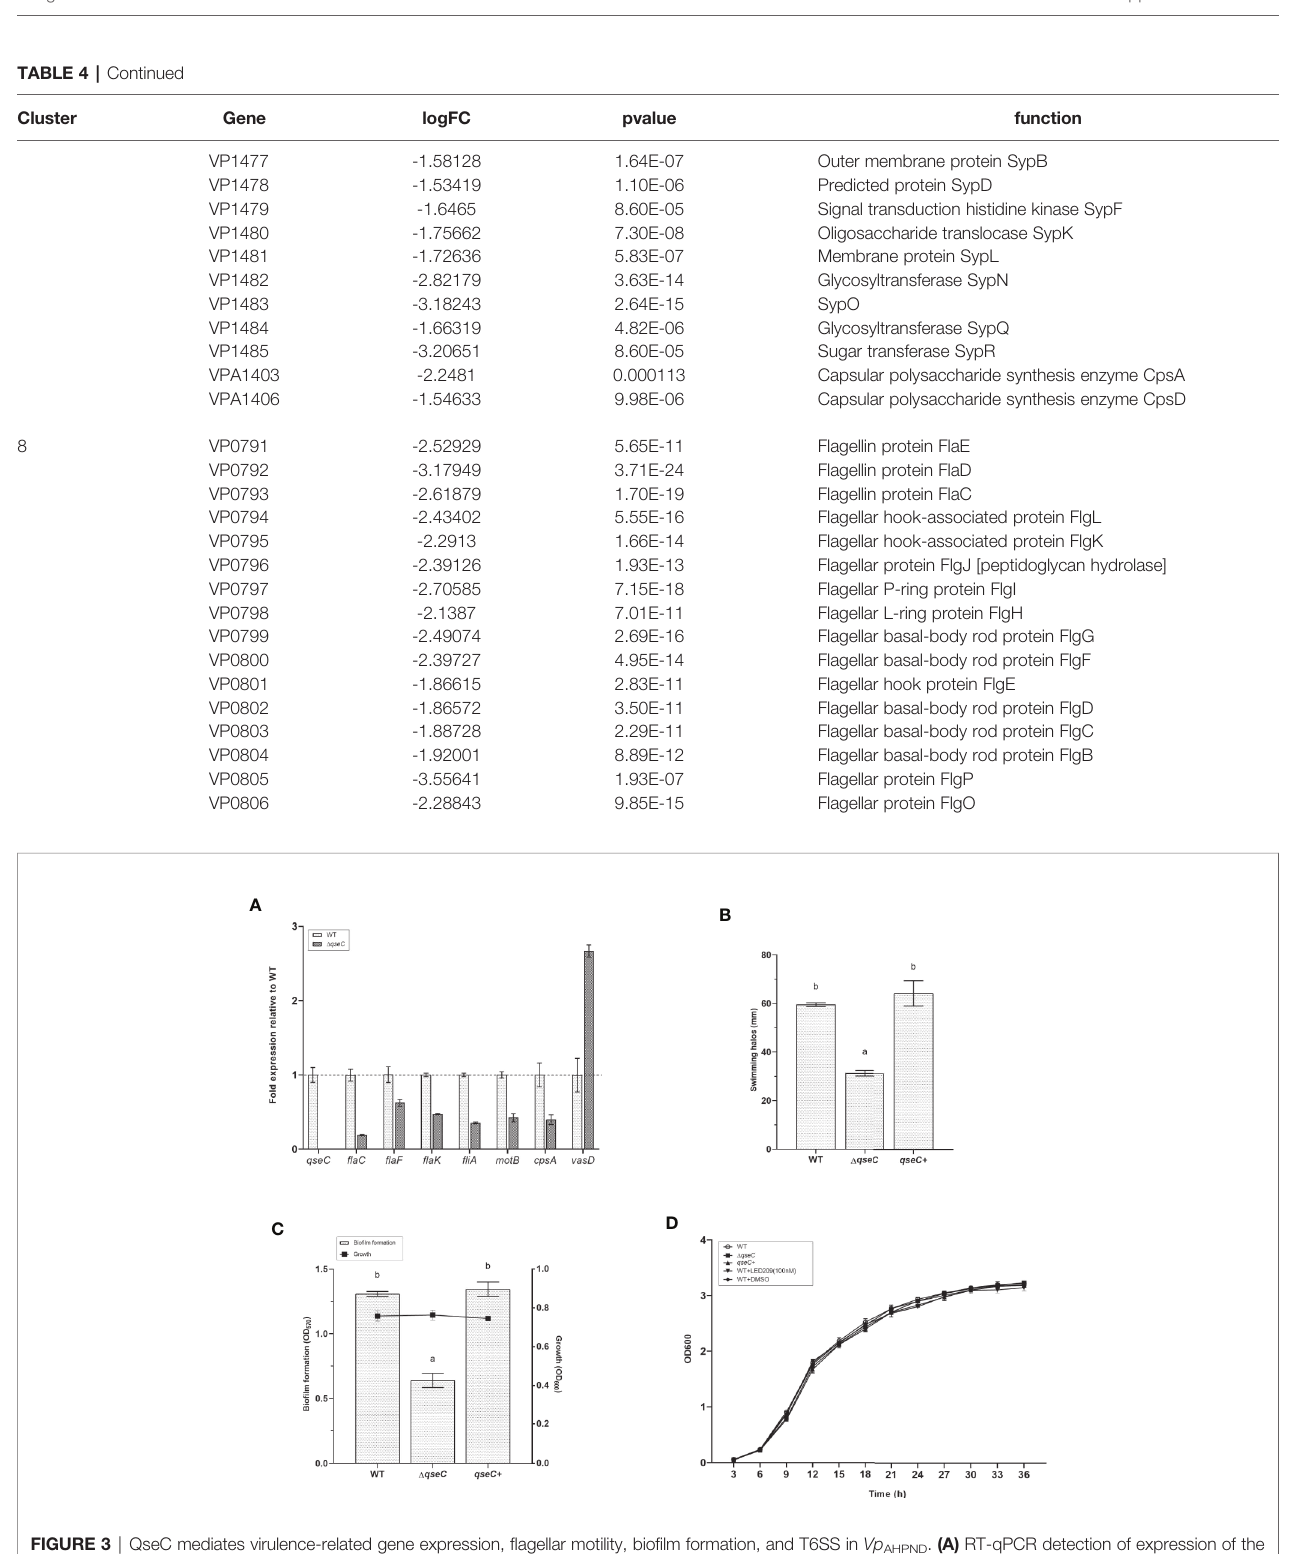
FIGURE 3 | QseC mediates virulence-related gene expression, fl agellar motility, bio fi lm formation, and T6SS in Vp AHPND . (A) RT-qPCR detection of expression of the virulence-related genes in wild type (WT) and D qseC mutant cultured to exponential phase. Genes normalized to recA , and fold change relative to wild type strain. All values were expressed as mean ± standard deviation (SD) of three biological replicates. (B) Swimming motility assays performed on soft agar plates after 21 h of incubation. The data were replotted from Figure 1B . Error bars indicated the SD of three independent experiments. Different letters indicated signi fi cant differences (one way ANOVA with Tukey ’ s post hoc test; p < 0.01). (C) Bio fi lm formation in different Vp AHPND strains. Error bars indicated the SD of three independent experiments. Different letters indicated signi fi cant differences (one way ANOVA with Tukey ’ s post hoc test; p < 0.01). (D) Impact of qseC deletion and catecholamine receptor antagonist LED209 on the growth of Vp AHPND 123. Error bars represented SD of three independent